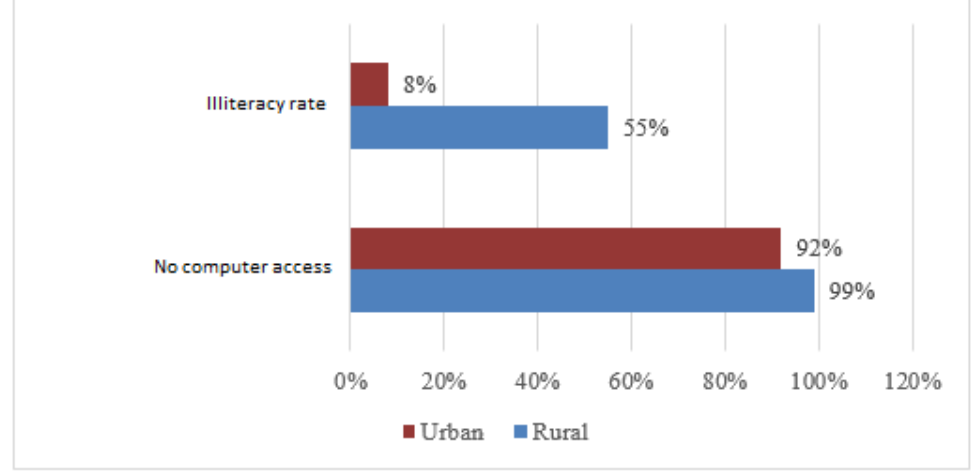
Figure 7. Population without computer access and the illiteracy rate. Source: INE/IBEP.